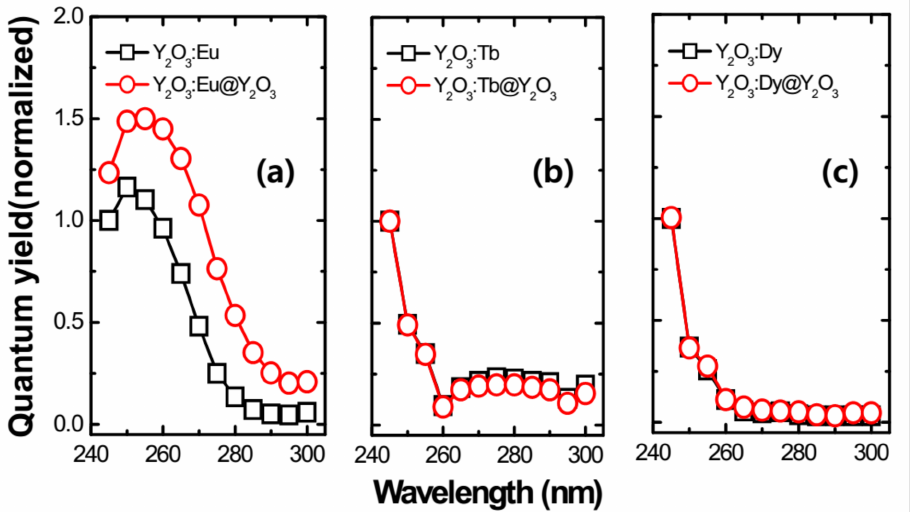
Figure 8. Relative quantum yield spectra of the RE-doped Y 2 O 3 core and Y 2 O 3 passive shell-coated Y 2 O 3 :RE core. ( a ) Relative quantum yield of 0.10 mM of Eu 3+ -doped Y 2 O 3 core and Y 2 O 3 :Eu@Y 2 O 3 , ( b ) relative quantum yield of 0.05 mM of Tb 3+ -doped Y 2 O 3 core and Y 2 O 3 :Tb@ Y 2 O 3 , ( c ) relative quantum yield of 0.05 mM of Dy 3+ -doped Y 2 O 3 core and Y 2 O 3 :Dy@ Y 2 O 3 . All the core samples were annealed at 550 ◦ C for 3 h and passive shells were annealed at 750 ◦ C for 3